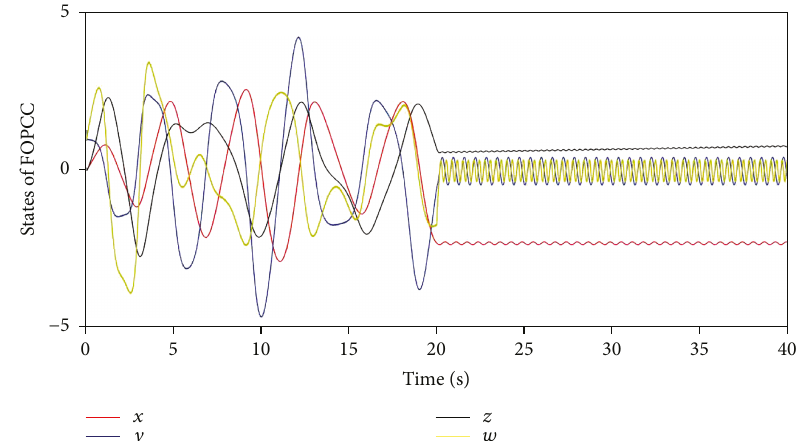
Figure 6: The time history of the states with the controller in e ff ect when t ≥ 20 s and the initial conditions for the simulation is 0, 1, 0, 1 , and the commensurate fractional order is q = 0 995